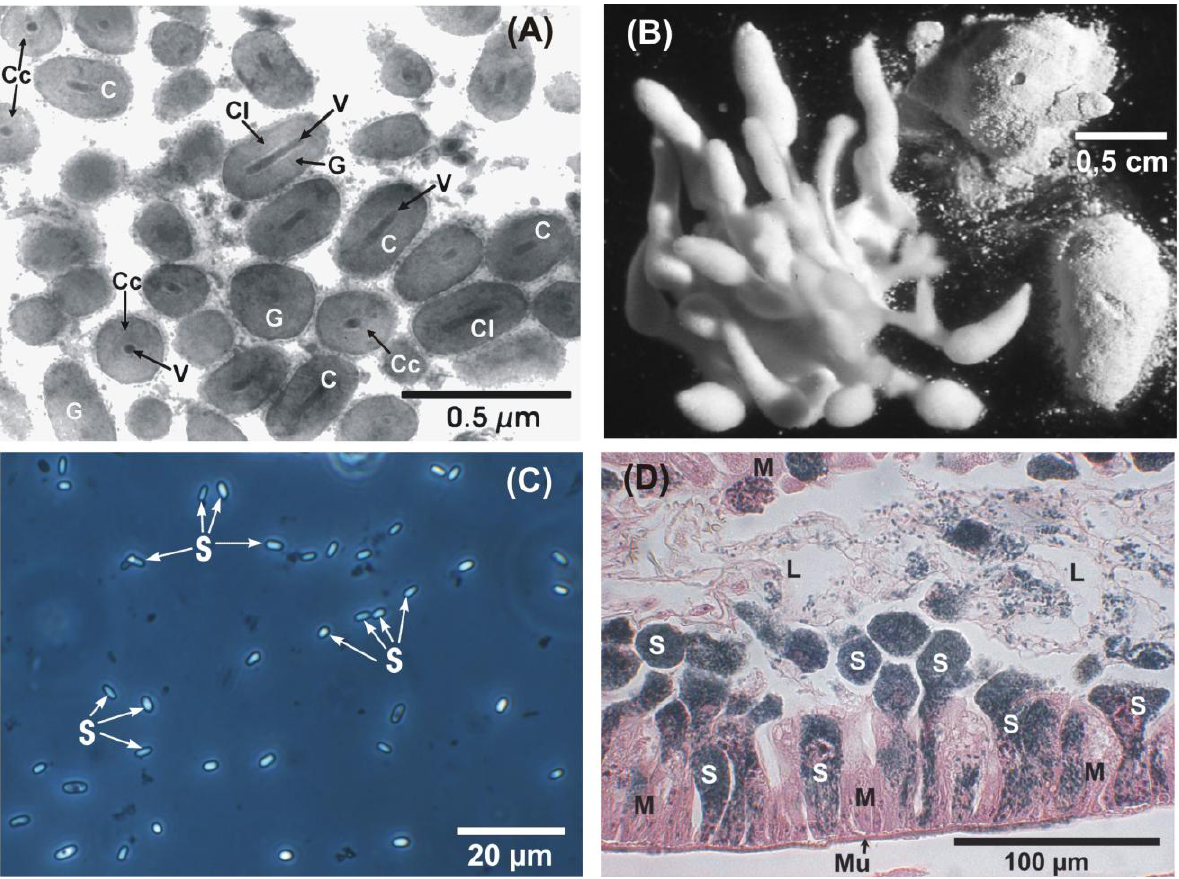
Figure 1. Important entomopathogens of the codling moth, Cydia pomonella. ( A ) Thin section of granulovirus (CpGV) with capsule-shaped virus occlusion bodies (C), formed by proteinaceous granulin (G). Each virus capsule (C) harbors one rod-shaped virion (V). Longitudinal sections (Cl) and cross sections (Cc) of virus capsules (transmission electron microscope); ( B ) Different morphologies of the entomopathogenic fungus, Beauveria bassiana , on three codling moth larvae (stereomicroscope); ( C ) Spores (S) of the microsporidium, Nosema carpocapsae (phase contrast microscope); ( D ) Longitudinal section of larval midgut epithelium (M) with heavy infection by N. carpocapsae . Rounded batches of the dark colored spores (S) are expelled from the cylindrical epithelium cells into the midgut lumen (L). Mu, muscularis of the midgut. (Bright field microscope, staining: Hematoxylin Heidenhain (cid:178)